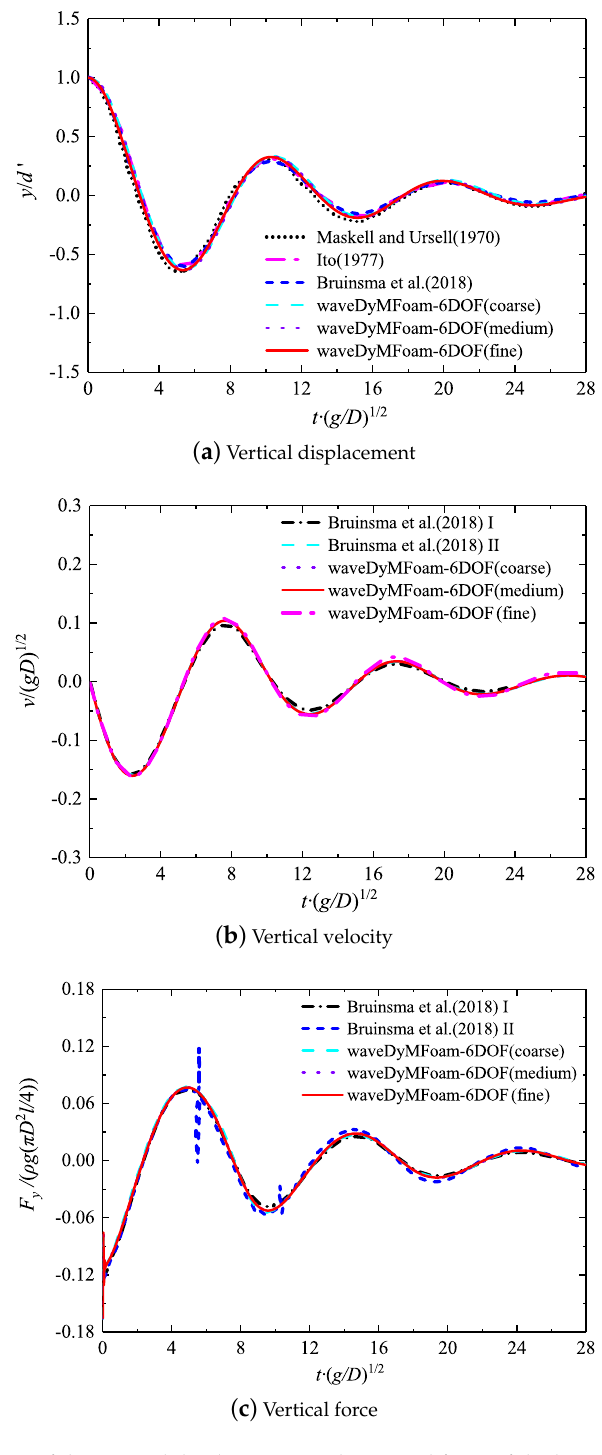
Figure 3. Comparisons of the vertical displacement, velocity and force of the heaving cylinder with the previous results. Here, g is the acceleration of